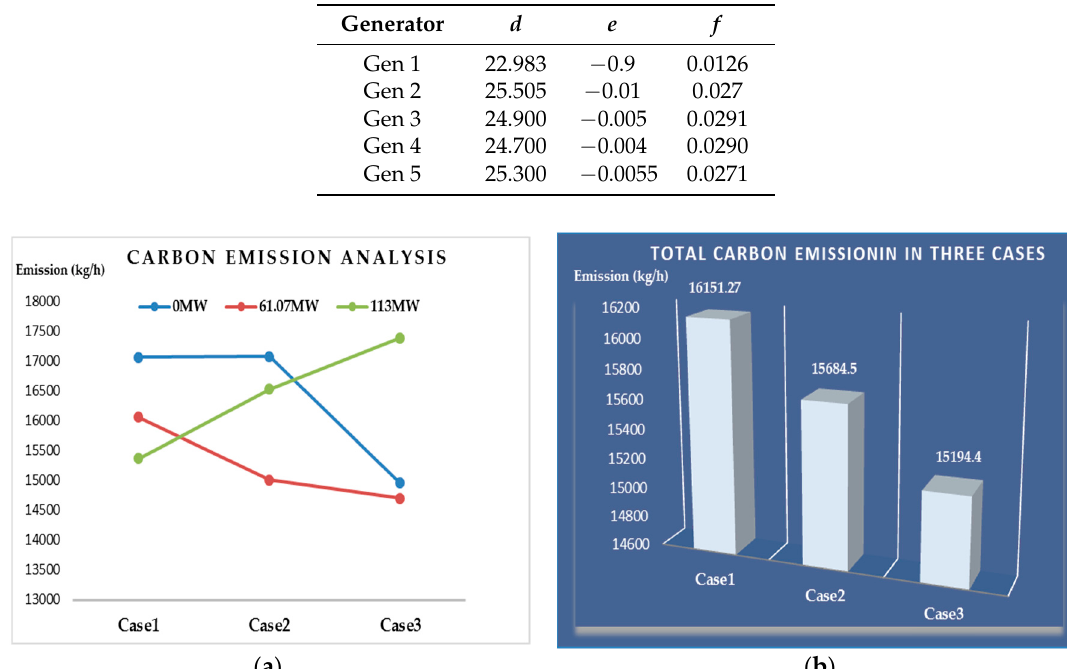
Figure 8. ( a ) Carbon emission considering wind distribution; ( b ) Total carbon emission.